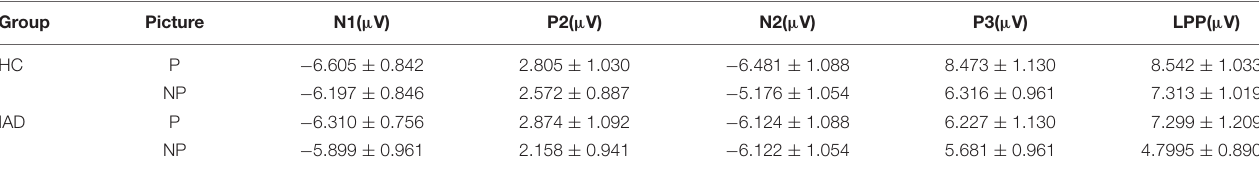
TABLE 2 | Descriptive statistics for event-related potential (ERP) data.